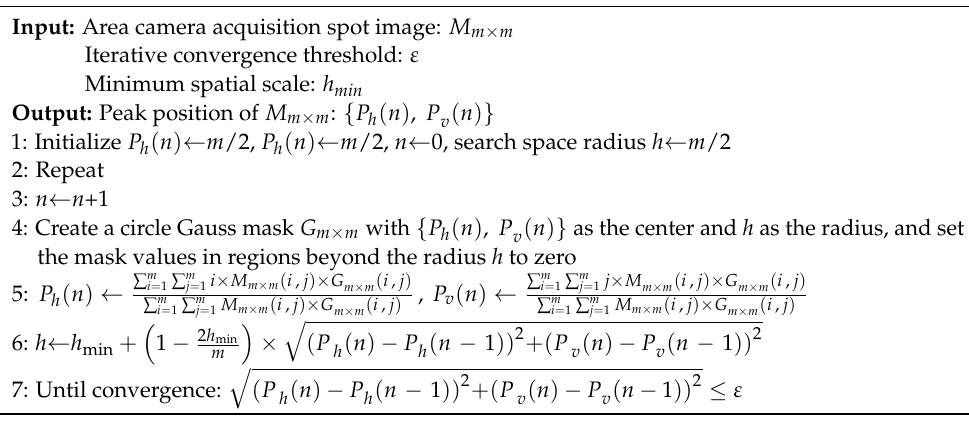
Algorithm 2. Fast spatial convergence peak-extraction